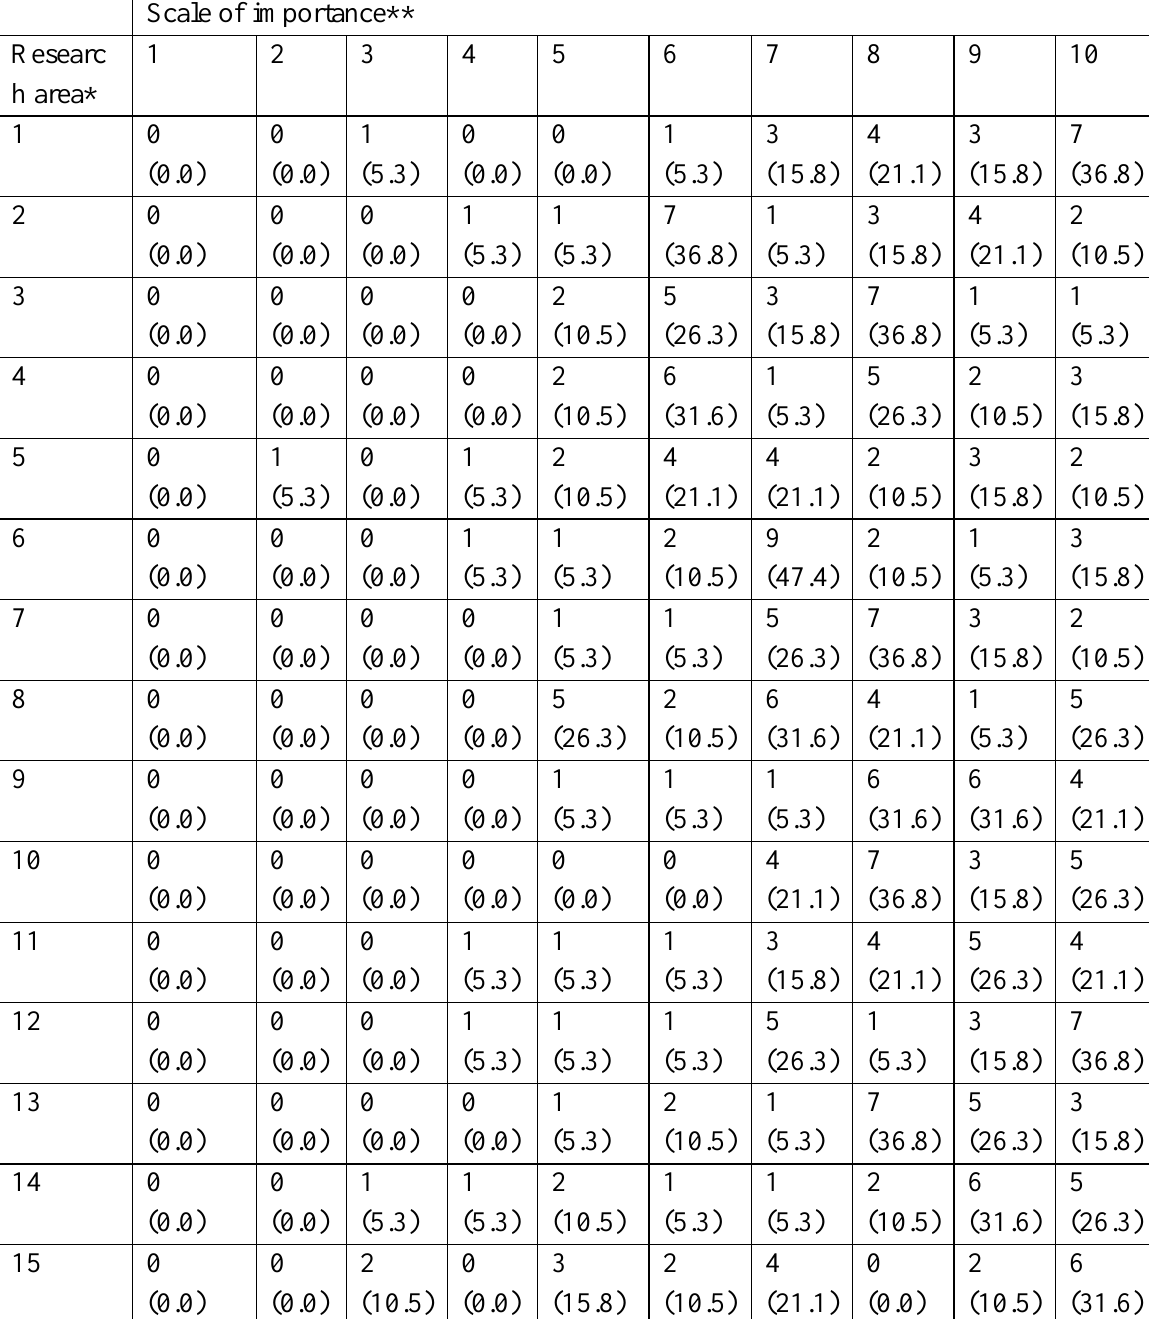
Table 3 Frequency Tabulation of Responses Regarding the Importance of Research Areas in Distance